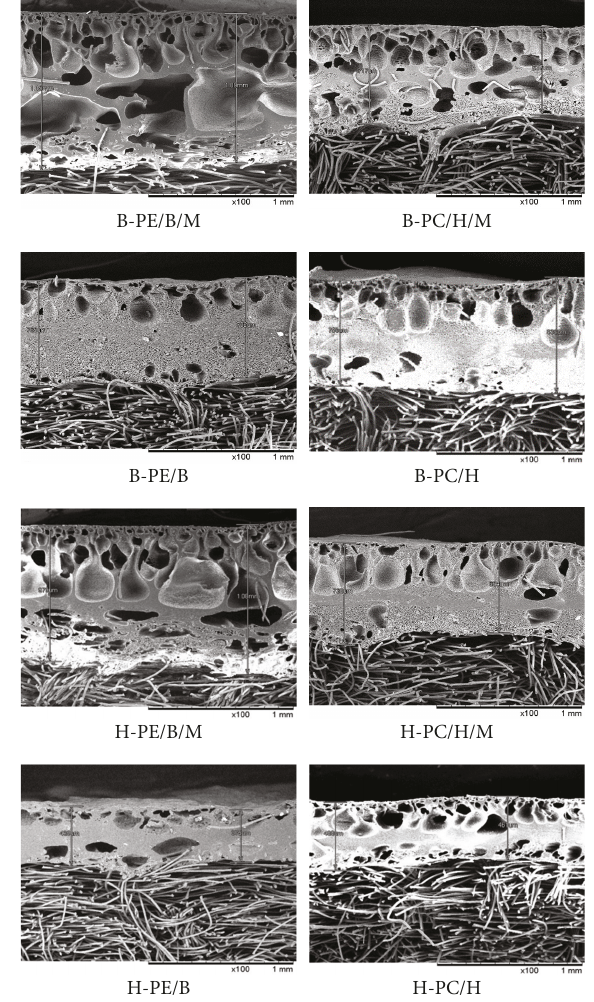
Figure 7: SEM micrographs of wet-type arti fi cial leathers based on nonwoven fabrics coated with various DMF-based